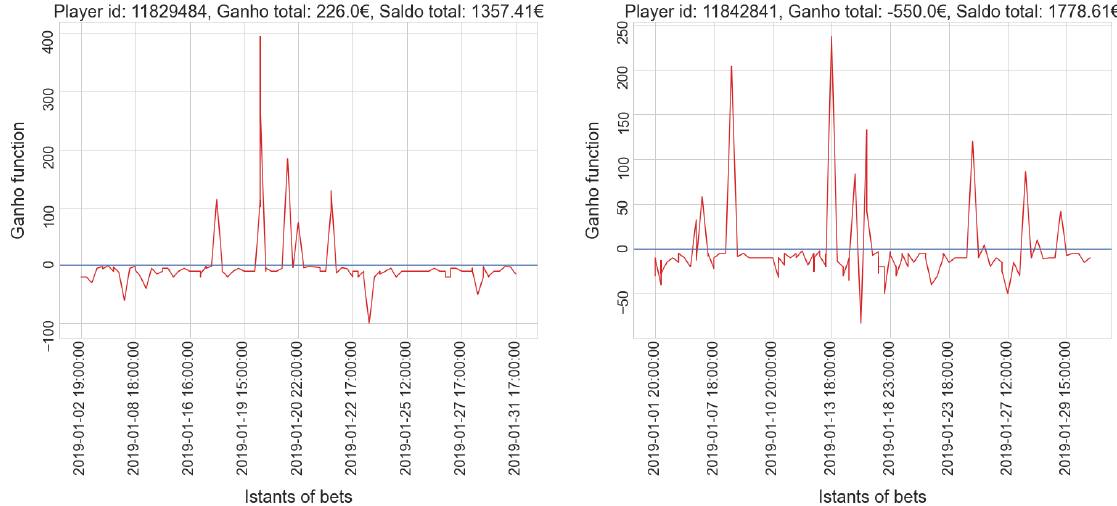
Figure 10. Time series plot of two players in Cluster 3.